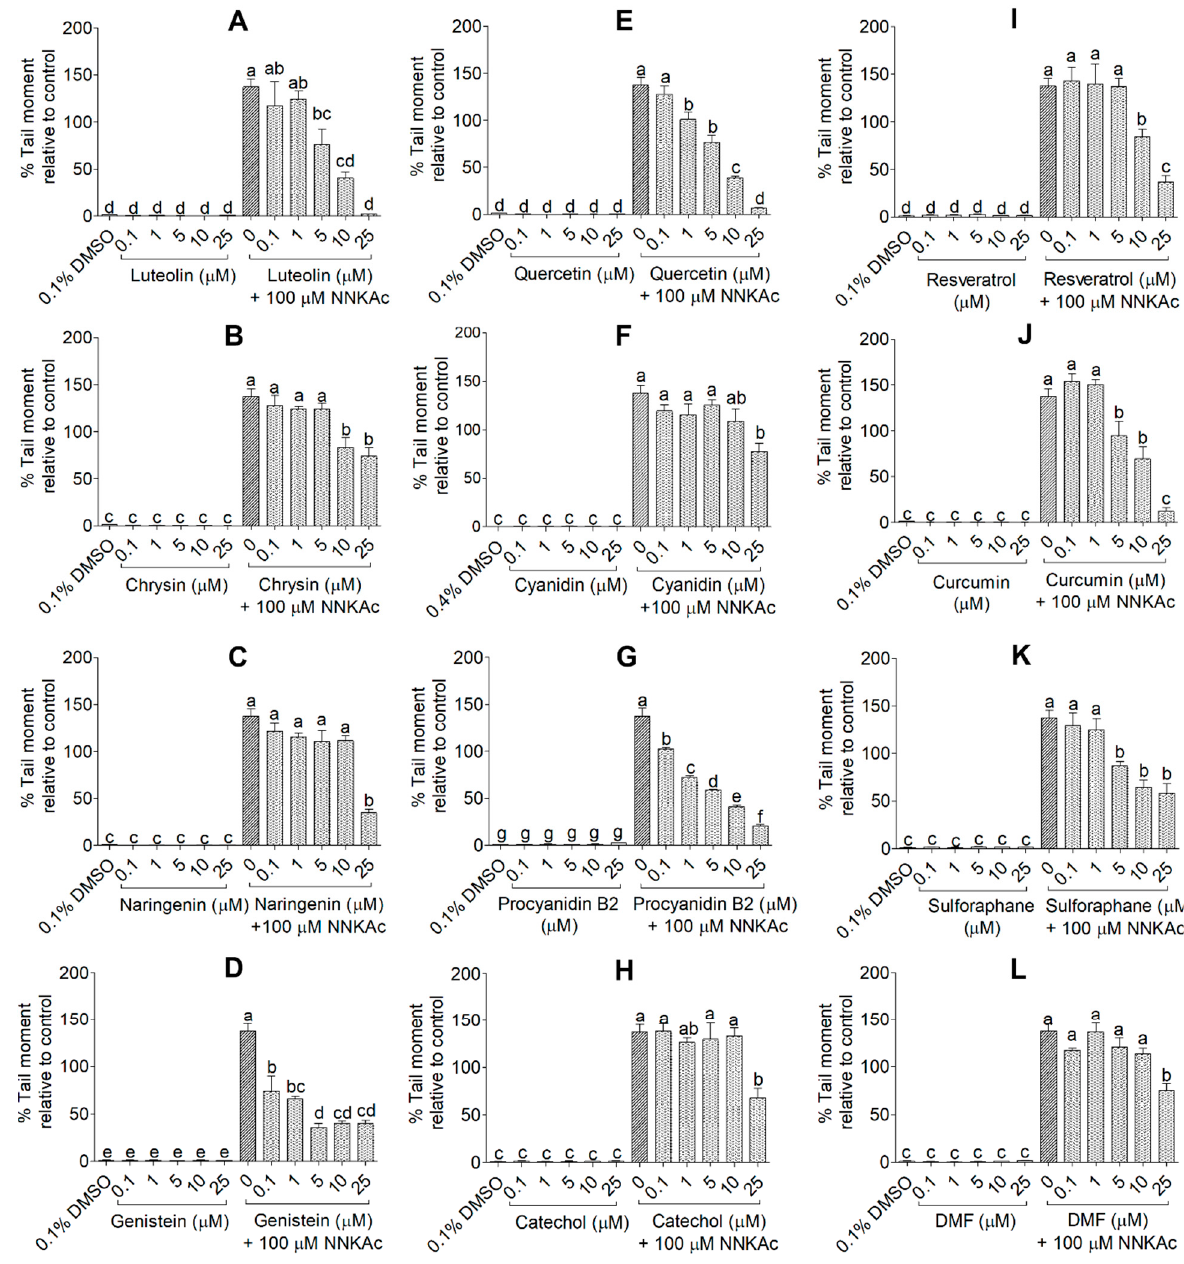
Figure 7. Effect of luteolin ( A ), chrysin ( B ), naringenin ( C ), genistein ( D ), quercetin ( E ), cyanidin ( F ), procyanidin B2 ( G ), catechol ( H ), resveratrol ( I ), curcumin ( J ), sulforaphane ( K ), and DMF ( L ) on NNKAc-induced DNA damage in BEAS-2B cells measured by comet assay. Cells were pre-treated with concentrations ranging from 0.1 to 25 µM of selected compounds for 3 h. Pre-treated cells were exposed to 100 µM NNKAc for another 3 h. DMSO (0.1%) was used as the vehicle control. Comets were imaged by fluorescence microscopy ( × 100 magnification). Percentage tail moment using at least 30 comets per each treatment was calculated by using the OpenComet plugin in ImageJ software (Version 1.53k, National Institute of Mental Health, Bethesda, MD, USA). Three independent studies were performed, and results were expressed as mean ± standard deviation. Statistical analysis of data was performed by one-way ANOVA and mean comparison was done by Tukey’s mean comparison method ( α = 0.05) using Minitab 19 statistical software (LLC, Pennsylvania, USA). Mean values that do not share similar letters in bar graphs are significantly different ( p < 0.05). Abbreviations: NNKAc: 4-[(acetoxymethyl)nitrosamino]-1-(3-pyridyl)-1-butanone, DMF: dimethyl fumarate, and DMSO: dimethyl sulfoxide.